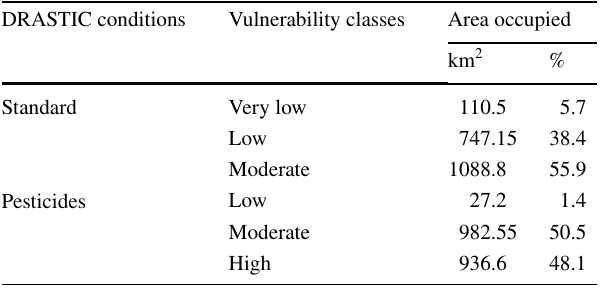
Table 11 Statistics of the single-parameter sensitivity